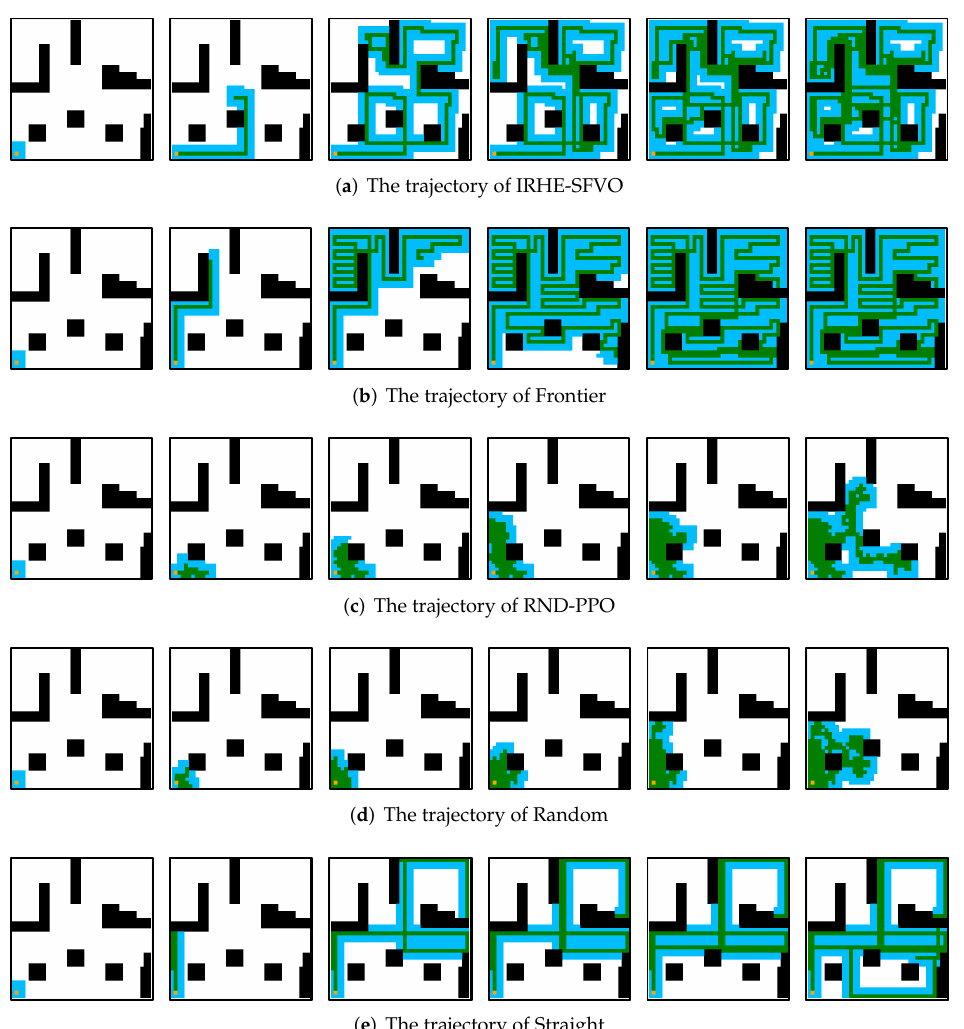
Figure 14. Sample trajectories of the competing approaches along with the coverage region in Test map 2. The orange point represents the initial location of the agent. The solid green lines represent the trajectories that the agent has traversed and the blue shaded region shows the explored